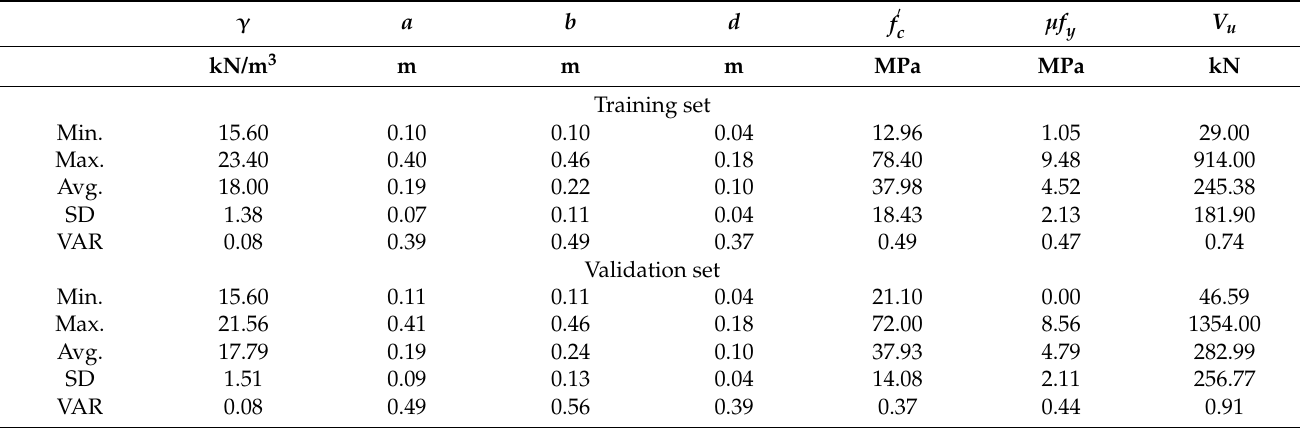
Table 1. Statistical analysis of collected